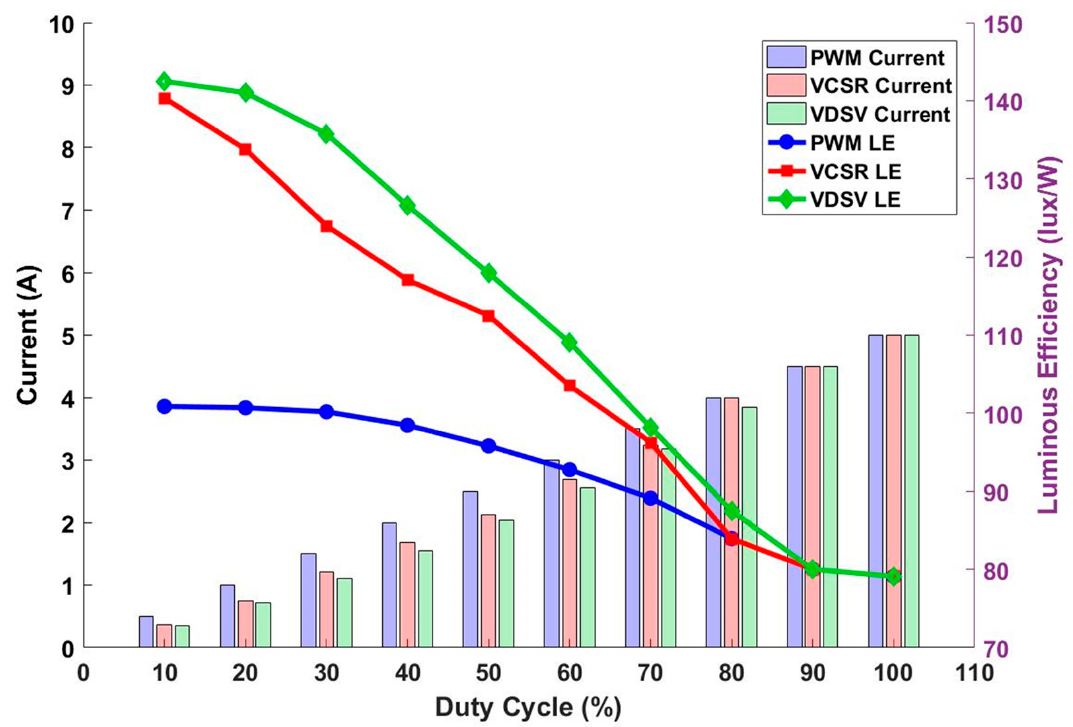
Electronics 2021 , 10 , x FOR PEER REVIEW Figure 14. Luminous efficiency curves and LED current measured by the proposed methods and PWM dimming.